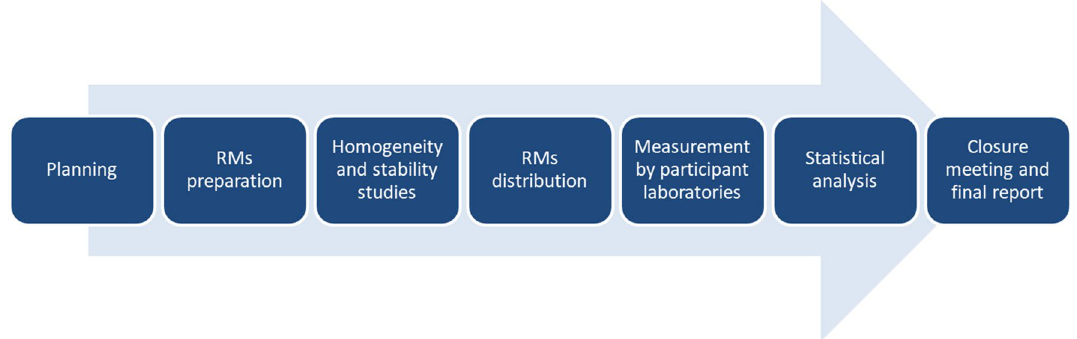
Figure 2. Process for the organization of PTs carried out in the multilateral cooperation